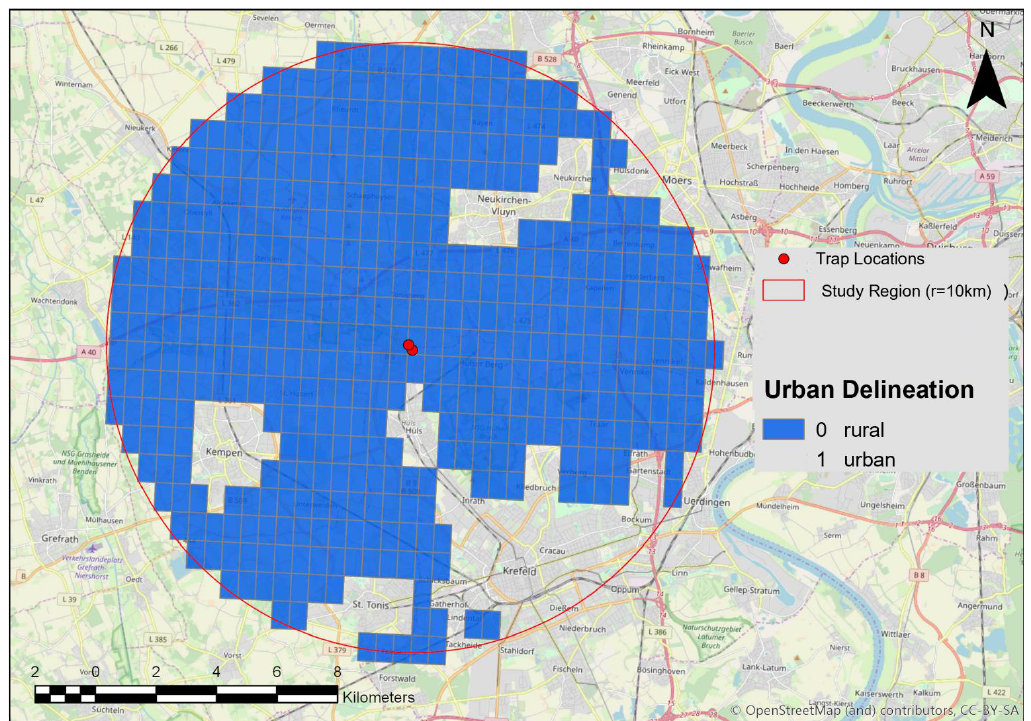
Figure 4. Classification of rural (blue) and urban (transparent) areas based on the 2012 CORINE land cover data within a 10 km buffer around the insect trap locations. Urban classification is based on the reassignment of urban classes from the original CORINE dataset and their spatial relationships to city administrative units. The majority of the study area was classified as rural.